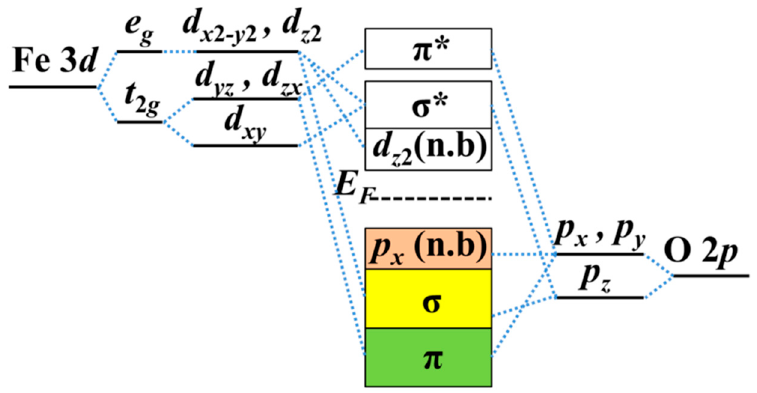
Figure 5. Schematic diagram of orbital energy-level of Fe 2 O 3 .